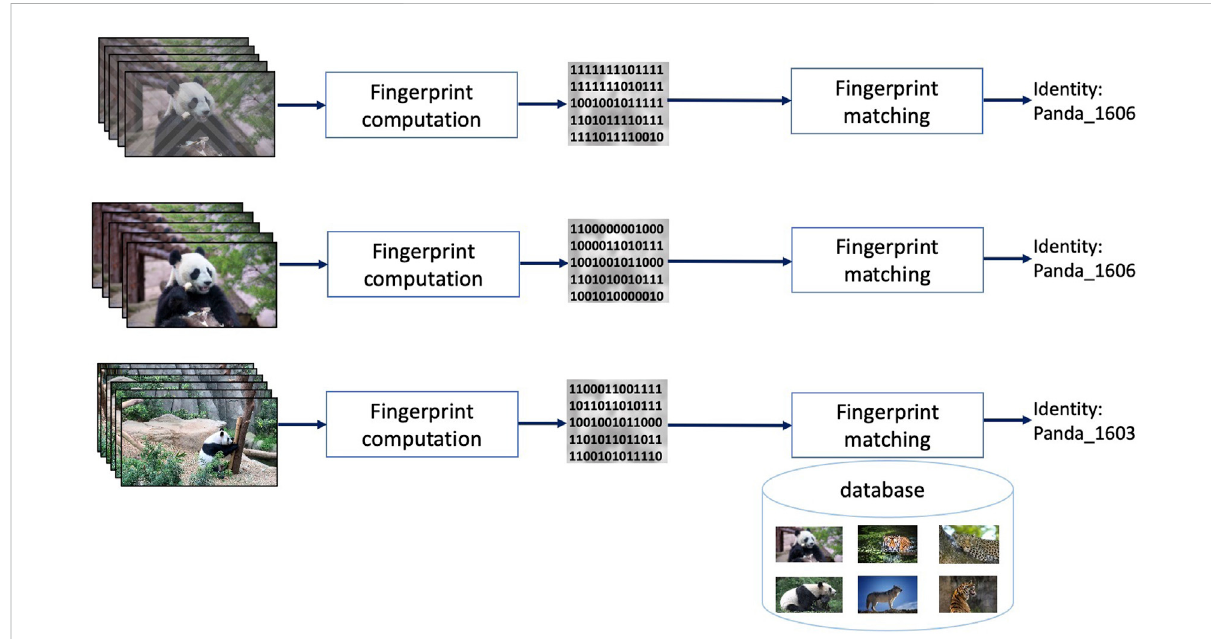
FIGURE 4 Video fi ngerprinting principle: a binary descriptor extracted from a query video ( fi ngerprint ) can unambiguously identify all the near-duplicated versions of that